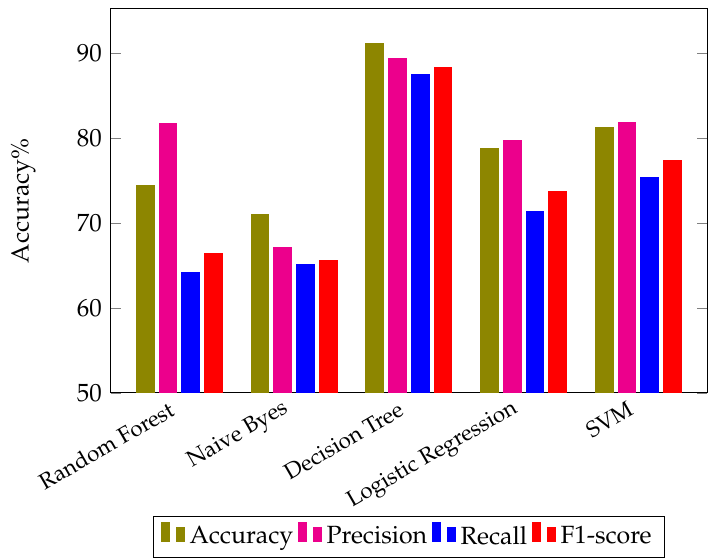
Figure 7. Machine learning Performance on Pfizer dataset.